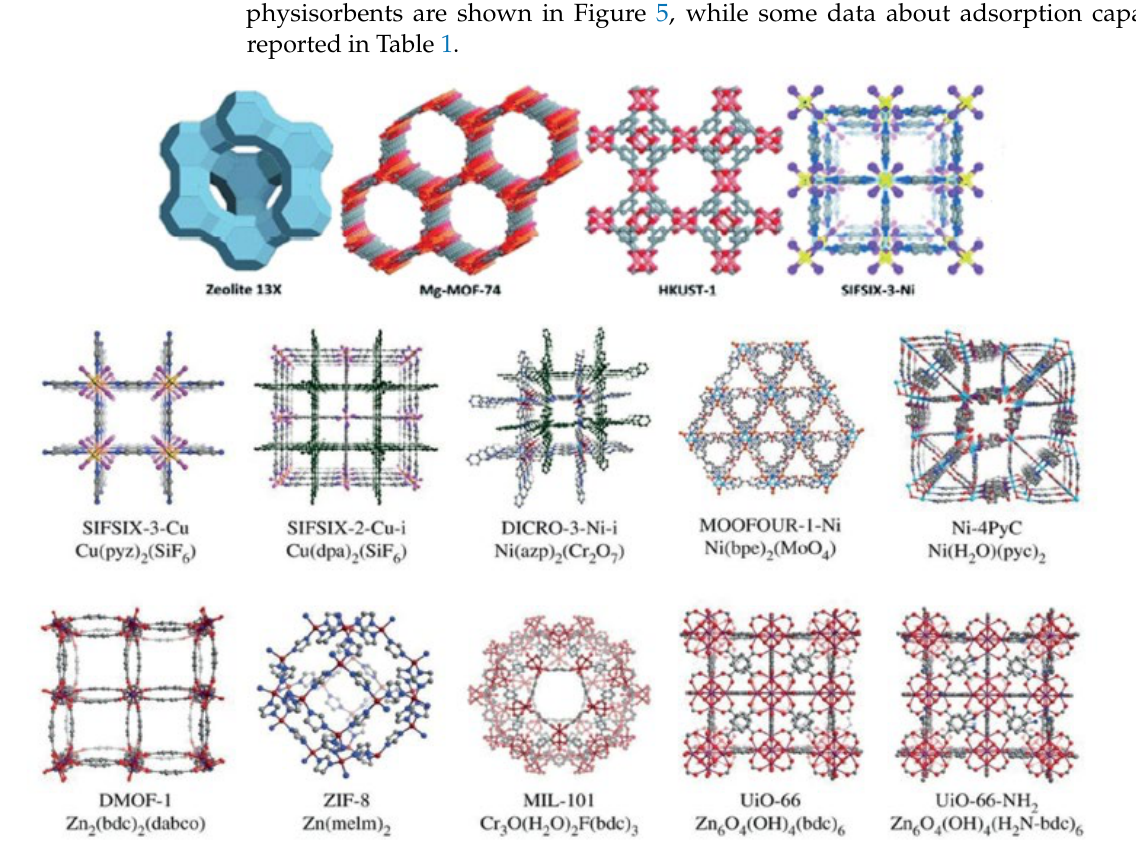
Table 1. Adsorption capacity of some physisorbents. Adapted from [6] .